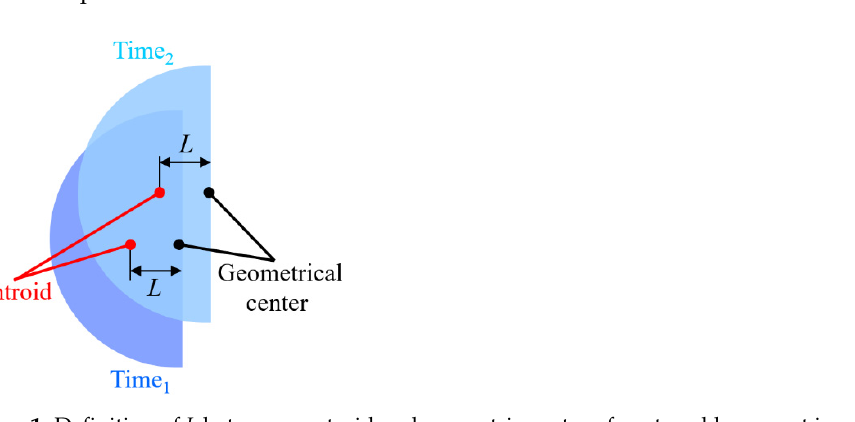
Figure 1. Definition of L between centroid and geometric center of captured laser spot images.